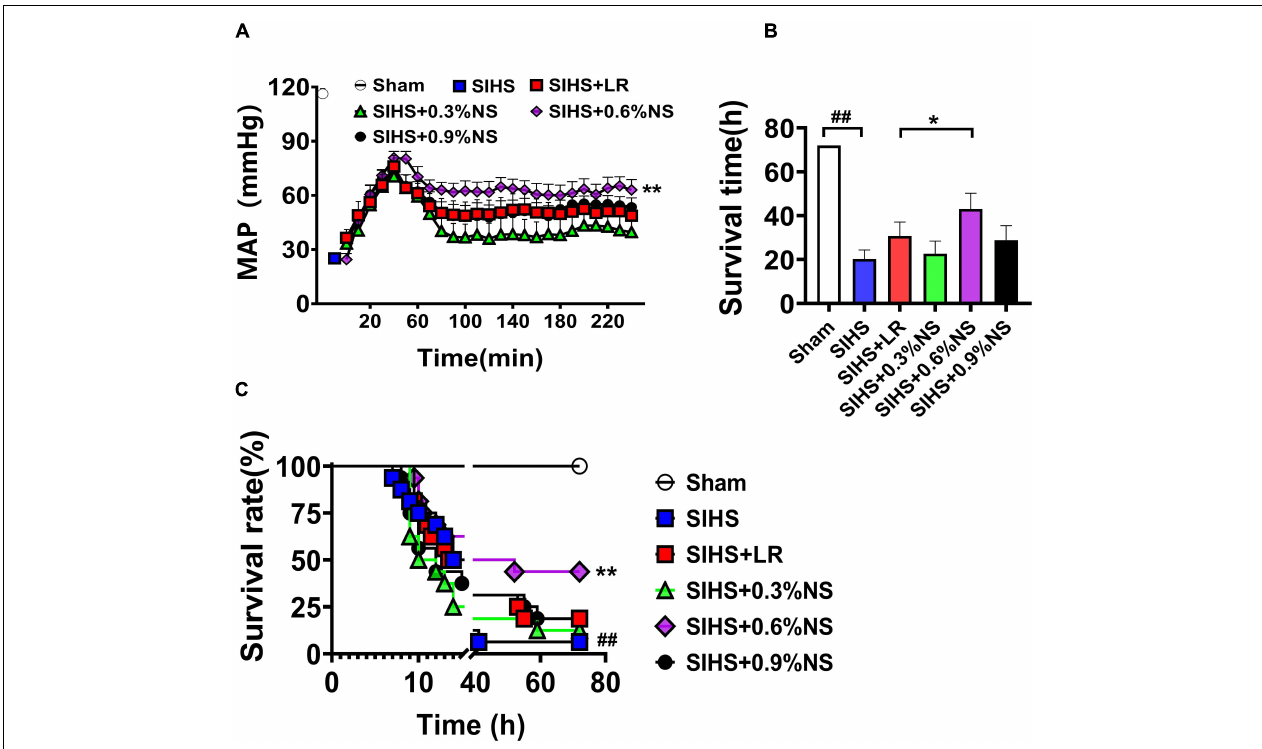
FIGURE 7 | Effects of different osmotic fluids on mean arterial pressure and survival with seawater immersion in hemorrhagic shock rats. (A) Mean arterial pressure (MAP) ( n = 8/group). (B) Survival time ( n = 16/group). (C) Survival rate ( n = 16/group). MAP, mean arterial pressure; Sham, Sham-operated group; SIHS, seawater immersion combined with hemorrhagic shock; LR, lactate Ringer’s solution; NS, normal saline. * p < 0.05 and ** p < 0.01, compared with the LR control group. ## p < 0.01, compared with the Sham